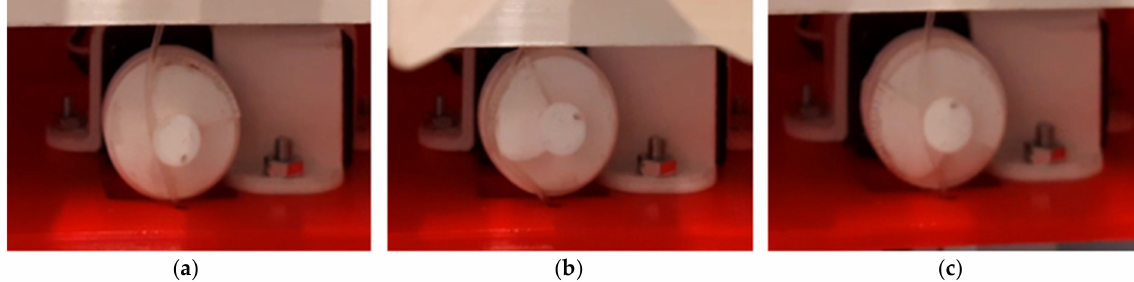
Figure 10. Cam system operation sequence: ( a ) wire hooking in the first handling phase; ( b ) wire traction and leaf-spring loading; ( c ) wire snap and elastic energy releasing.